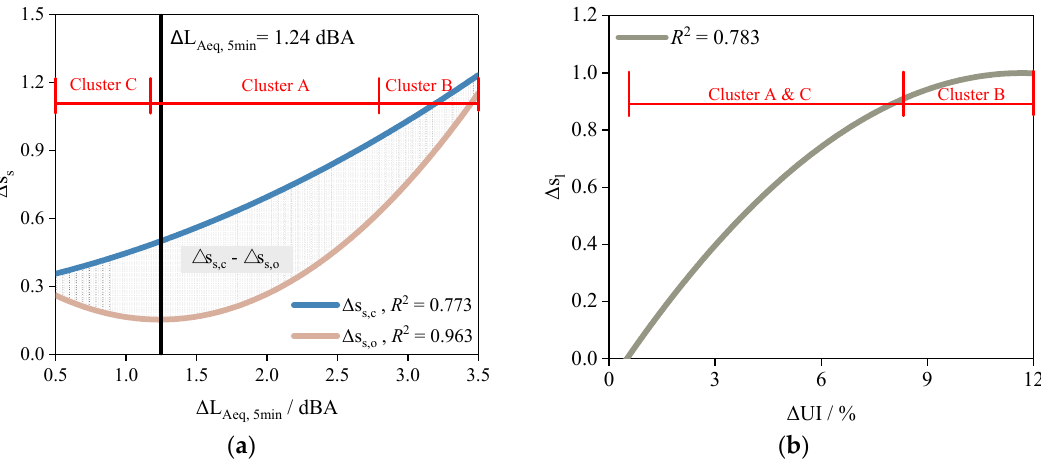
Figure 6. Fitting analysis of the subjective and objective variations of ( a ) soundscape and ( b ) lightscape.